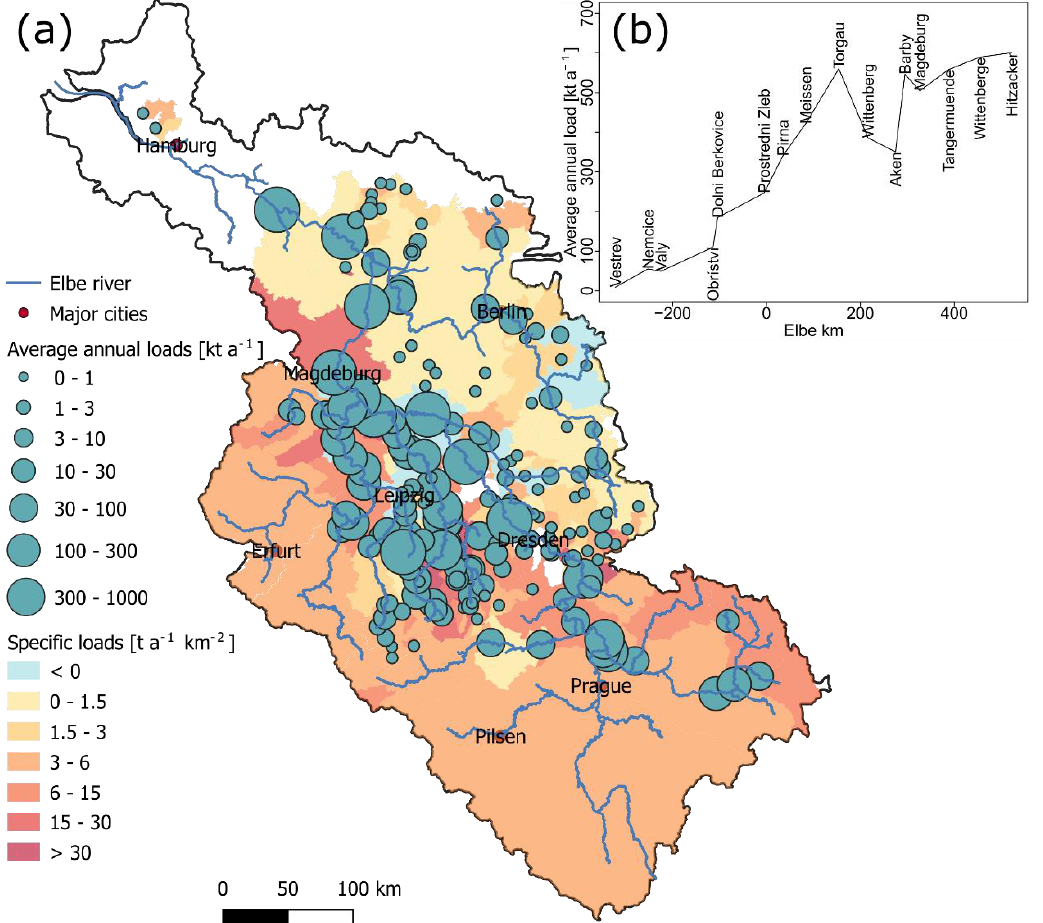
Figure 2. ( a ) Spatial distribution of average annual suspended sediment loads (circles) and specific loads (color of subcatchments) in the Elbe basin. ( b ) Longitudinal profile of average annual loads along the Elbe River. The kilometrage corresponds to the system of the German Waterways and Shipping Administration (WSV) where zero corresponds to the Czech-German border. Table 2. Average annual suspended sediment loads ( 𝑆𝑆𝐿 𝑎 ̅̅̅̅̅̅̅ ) and specific loads of the Elbe and its tributaries.